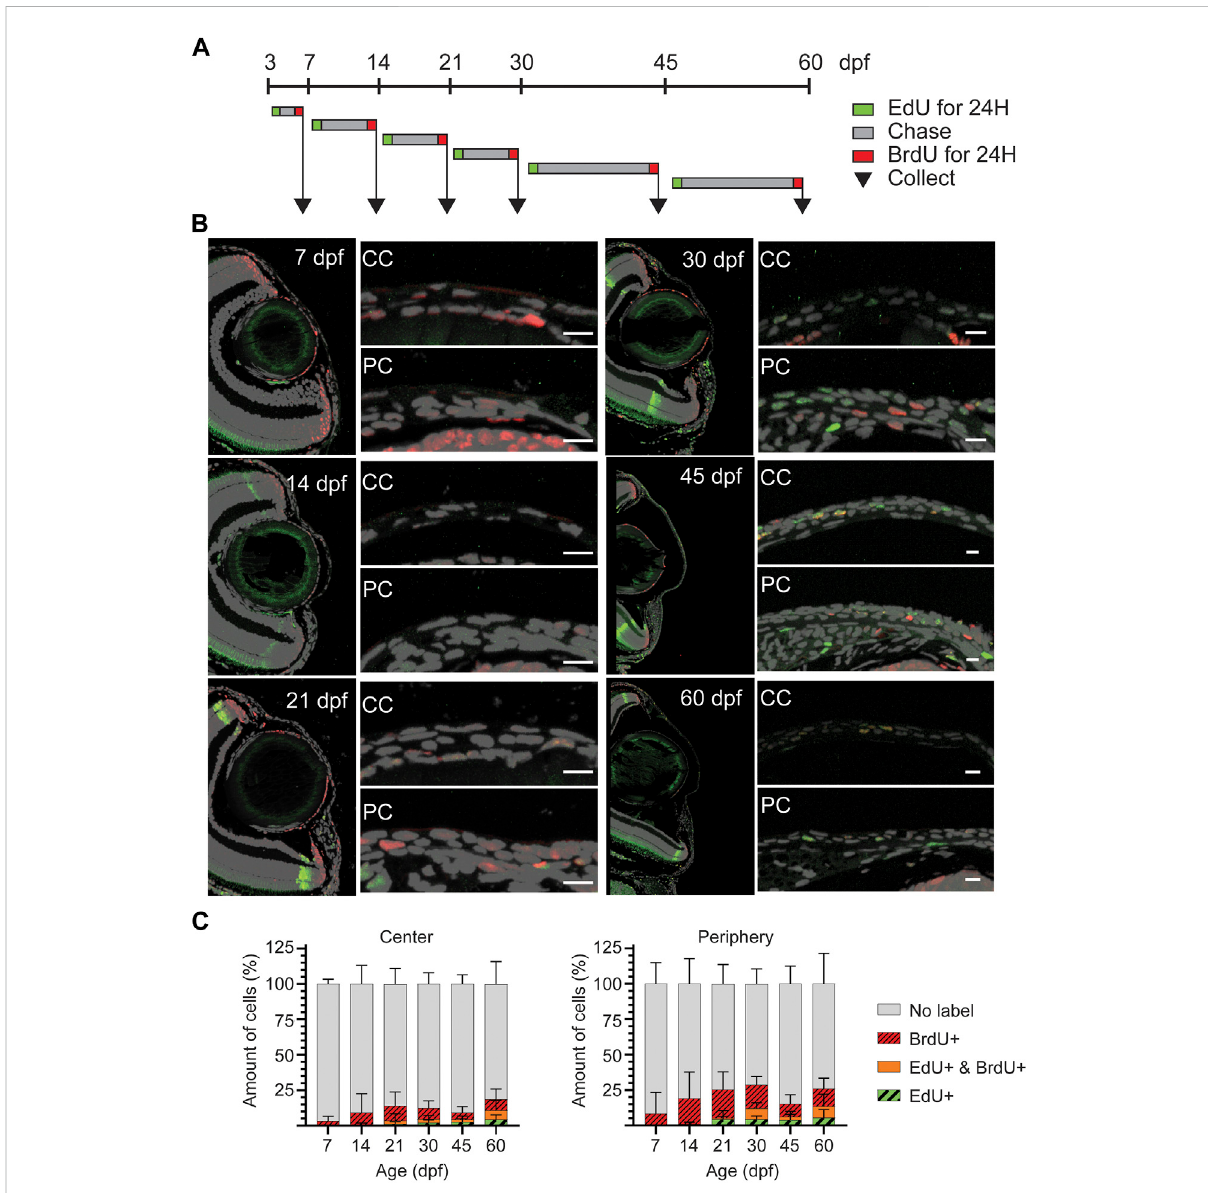
EdU/BrdU double-labeling on zebra fi sh cornea. (A) EdU (green) was administered to the fi sh for 24 h, followed by a chase period of 3 – 15 days. Then,BrdU(red)wasadministeredfor24 h,andsampleswerecollected. (B) EdU(green)andBrdU(red)stainingon5 µmparaf fi nsections.Thepanel shows the overview of the anterior eye, and central as well as peripheral/limbal regions of the cornea. (C) Quanti fi cation of EdU+, BrdU+, double positive, and EdU/BrdU-negative cells on the central region (left), and the peripheral region (right). Results represent mean ± SD (n = 6 – 9). The mean value of 2 — 3 sections from the middle of the eye were used per fi sh. Scale bars: 20 µm. CC, central regions; PC, peripheral/limbal